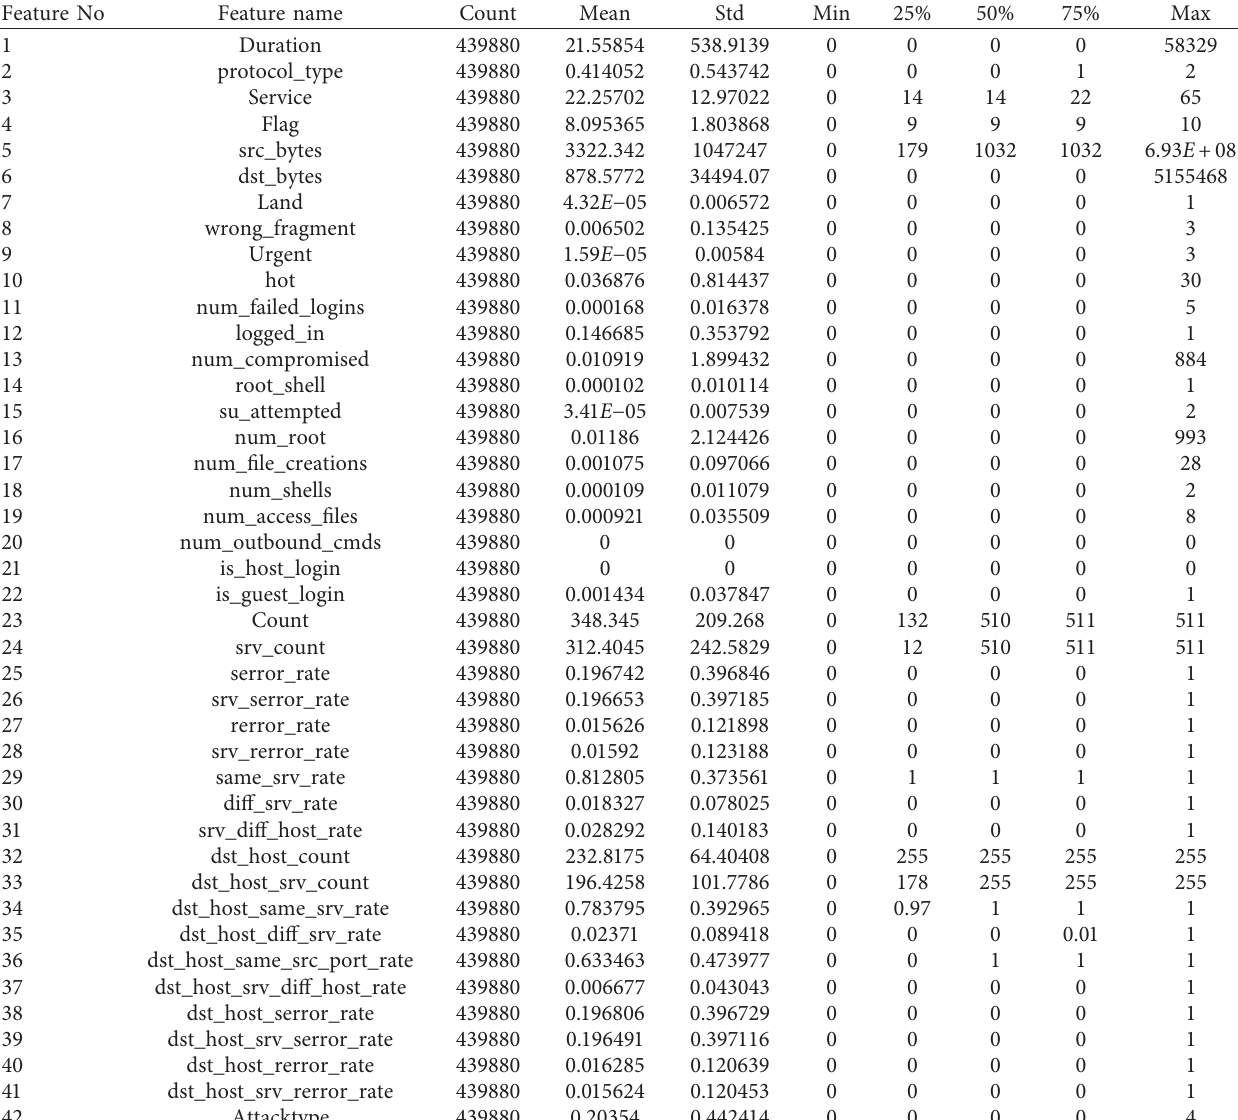
Table 4: Statistical analysis of KDD dataset.